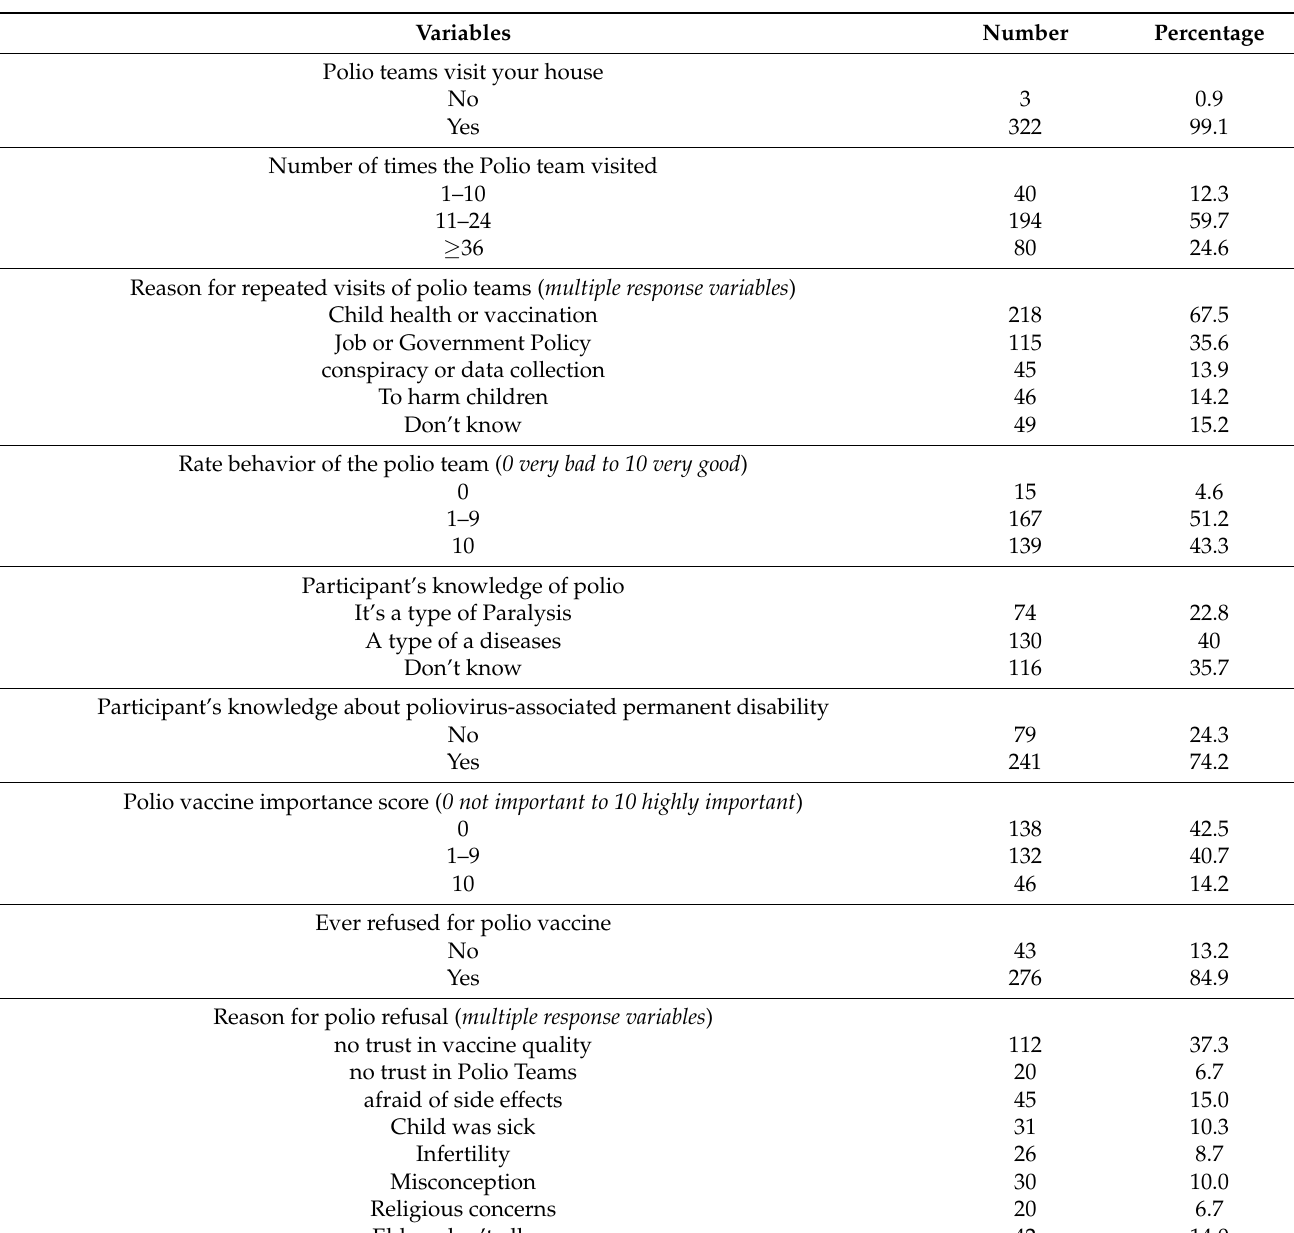
Table 2. Knowledge, attitude, and perceptions of the community regarding polio vaccination in